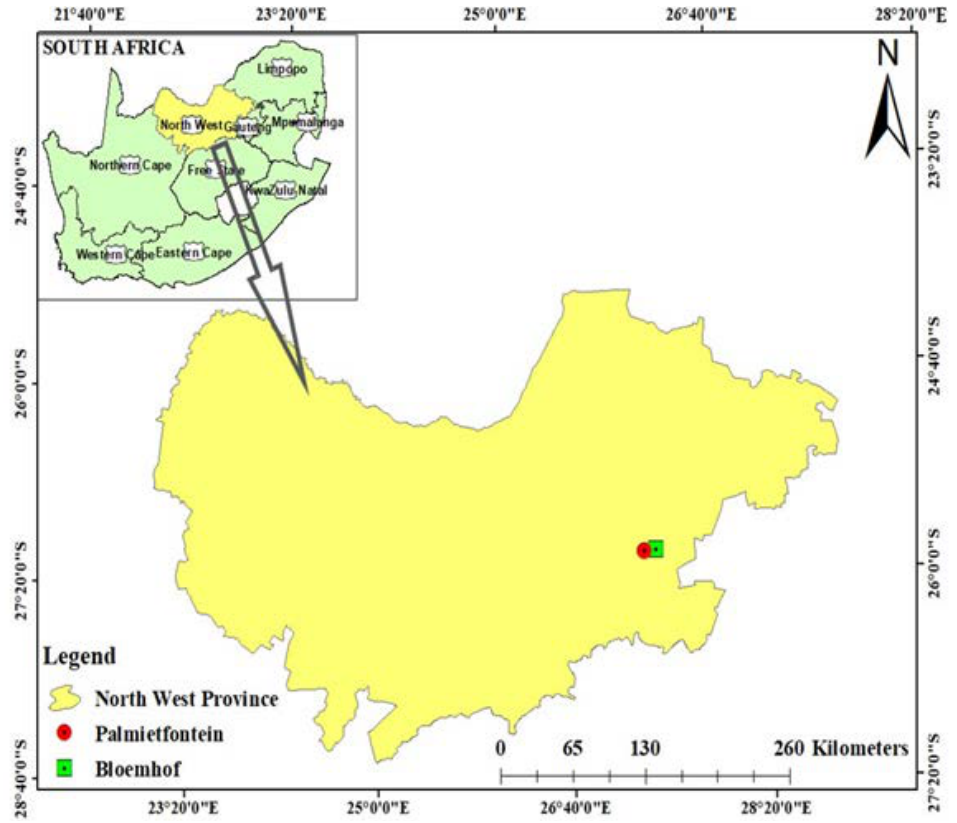
Figure 1. Map showing the sampling